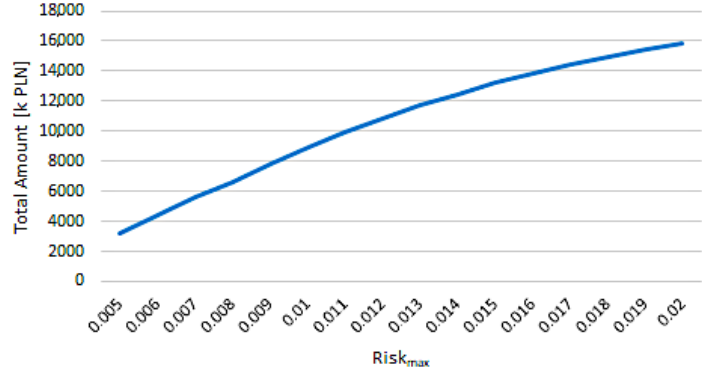
Figure 7. Total amount of all selected